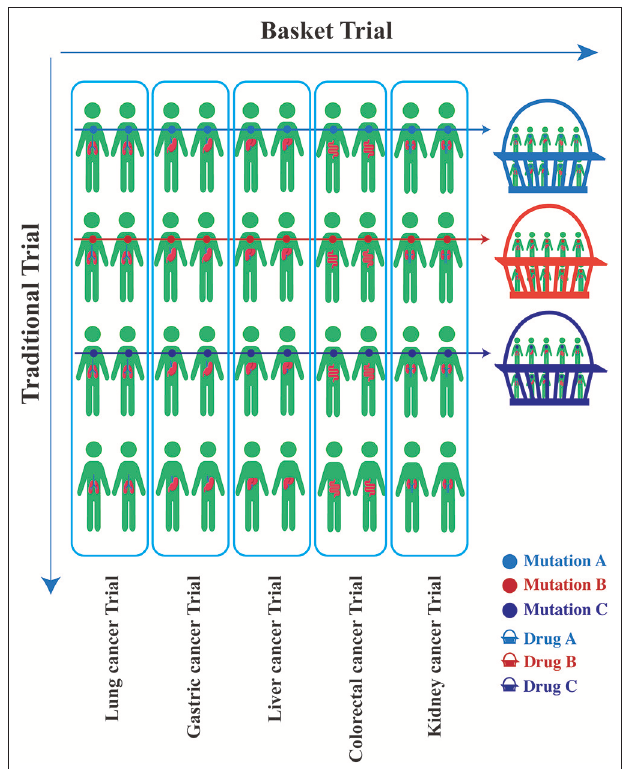
FIGURE 2 | Unlike traditional clinical trials which focus on patients with a single cancer histology, the core organizing principle of basket trials is concentrated on a specific genomic alteration found in the tumor, regardless of where the cancer originated. A basket trial tests the effect of one drug (Drug A/B/C) that targets the same genomic alteration (Mutation A/B/C) across a variety of tumor